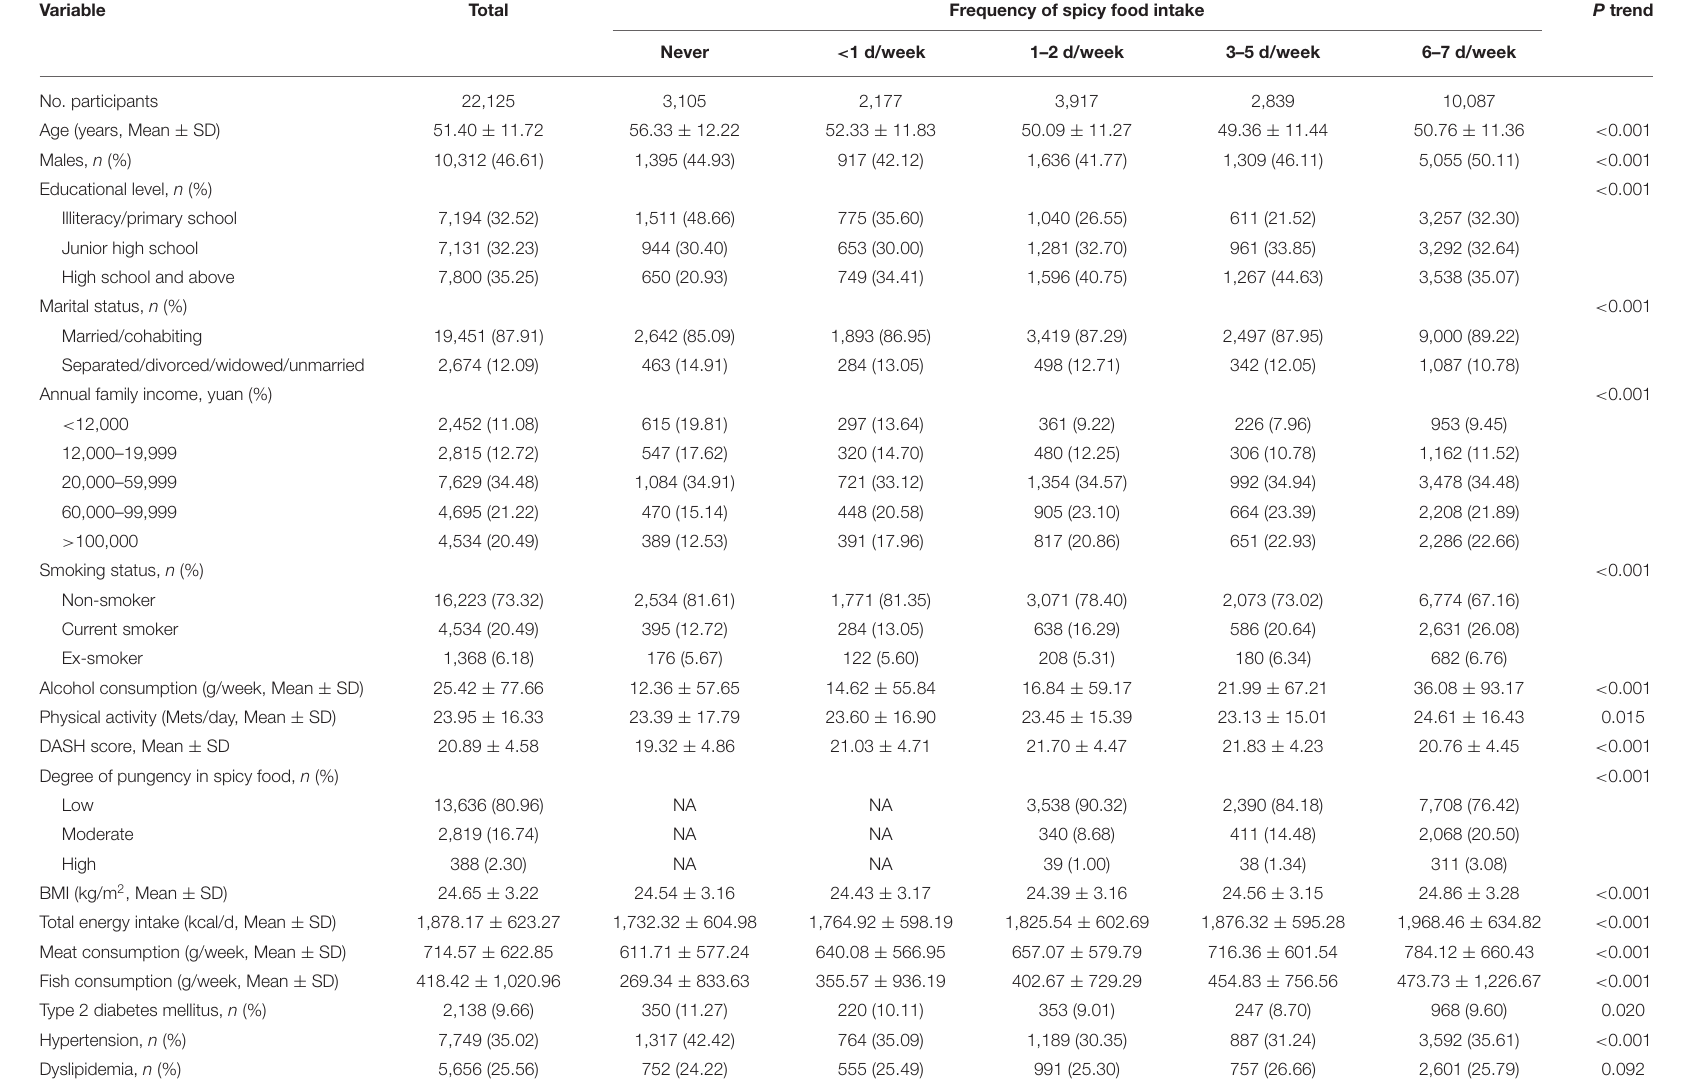
TABLE 1 | Characteristics of the participants according to the frequency of spicy food intake.